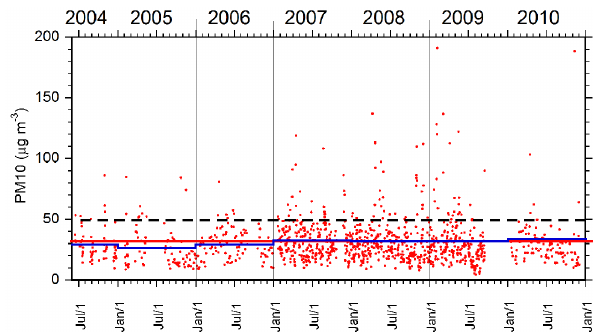
Fig. 1. Temporal evolution of PM 10 at Lampedusa in the period June 2004–December 2010. The black dashed line represents the EU daily threshold value of 50µgm − 3 . The red line is the mean PM 10 over the whole sampling period and the blue one represent the annual